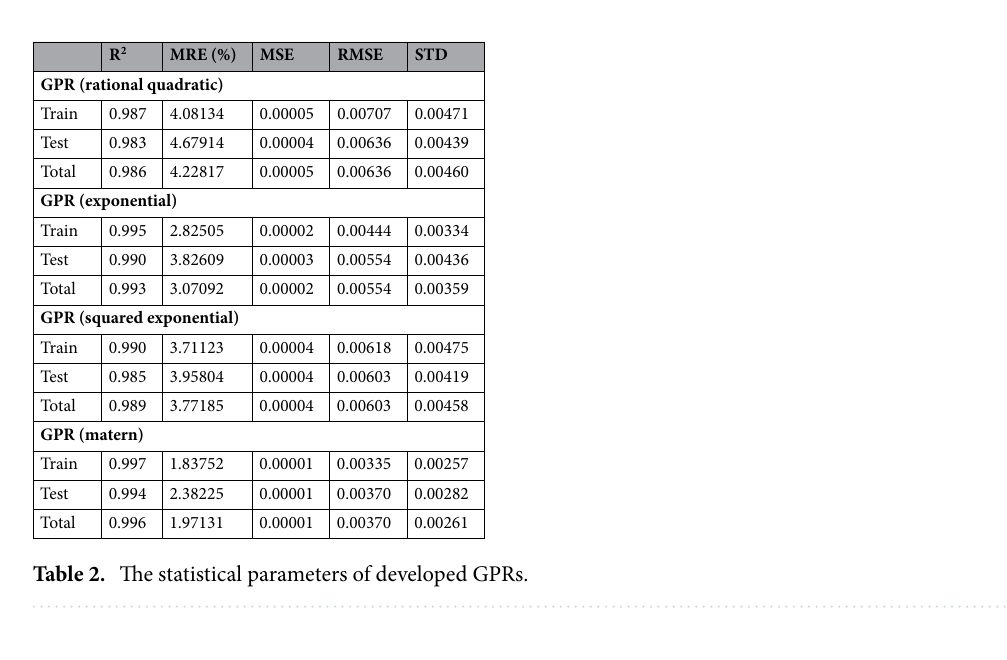
Figure 3. The sensitivity analysis for frost thermal conductivity.